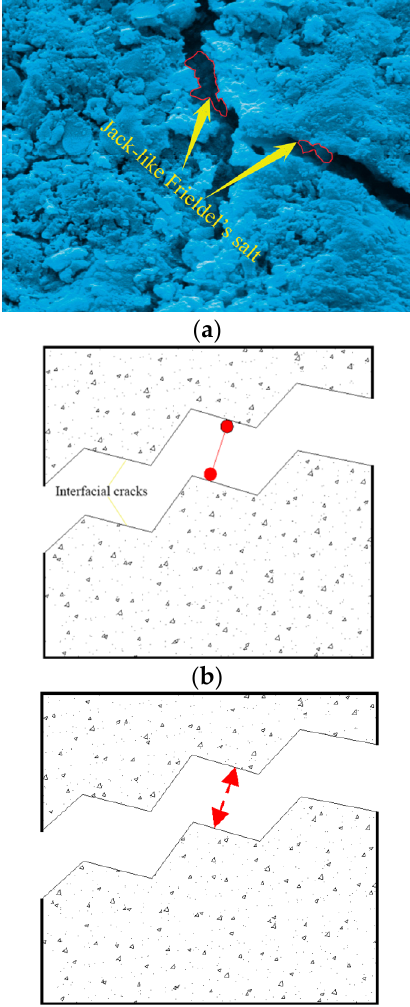
Figure 10. Friedel’s salt working model in young specimens. ( a ) SEM image of the 10-day-oldspecimen. ( b ) Jack working behavior of Friedel’s salt; the jack can be represented by a single-direction hinge. ( c ) Repulsive force model of Friedel’s salt with jack working behavior.